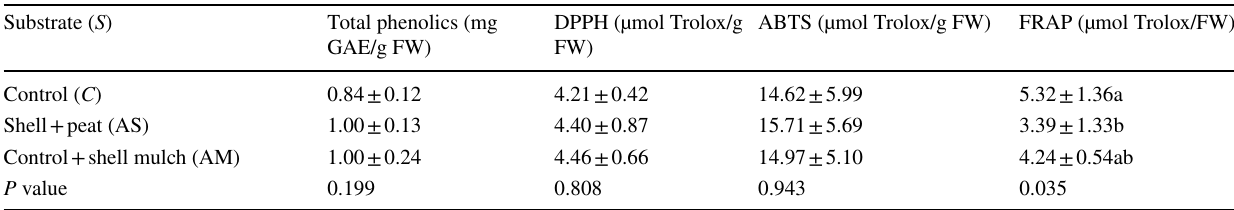
Table 5 Influence of the substrate on total phenolic and antioxidant activities of green bean pods 60 days after sowing